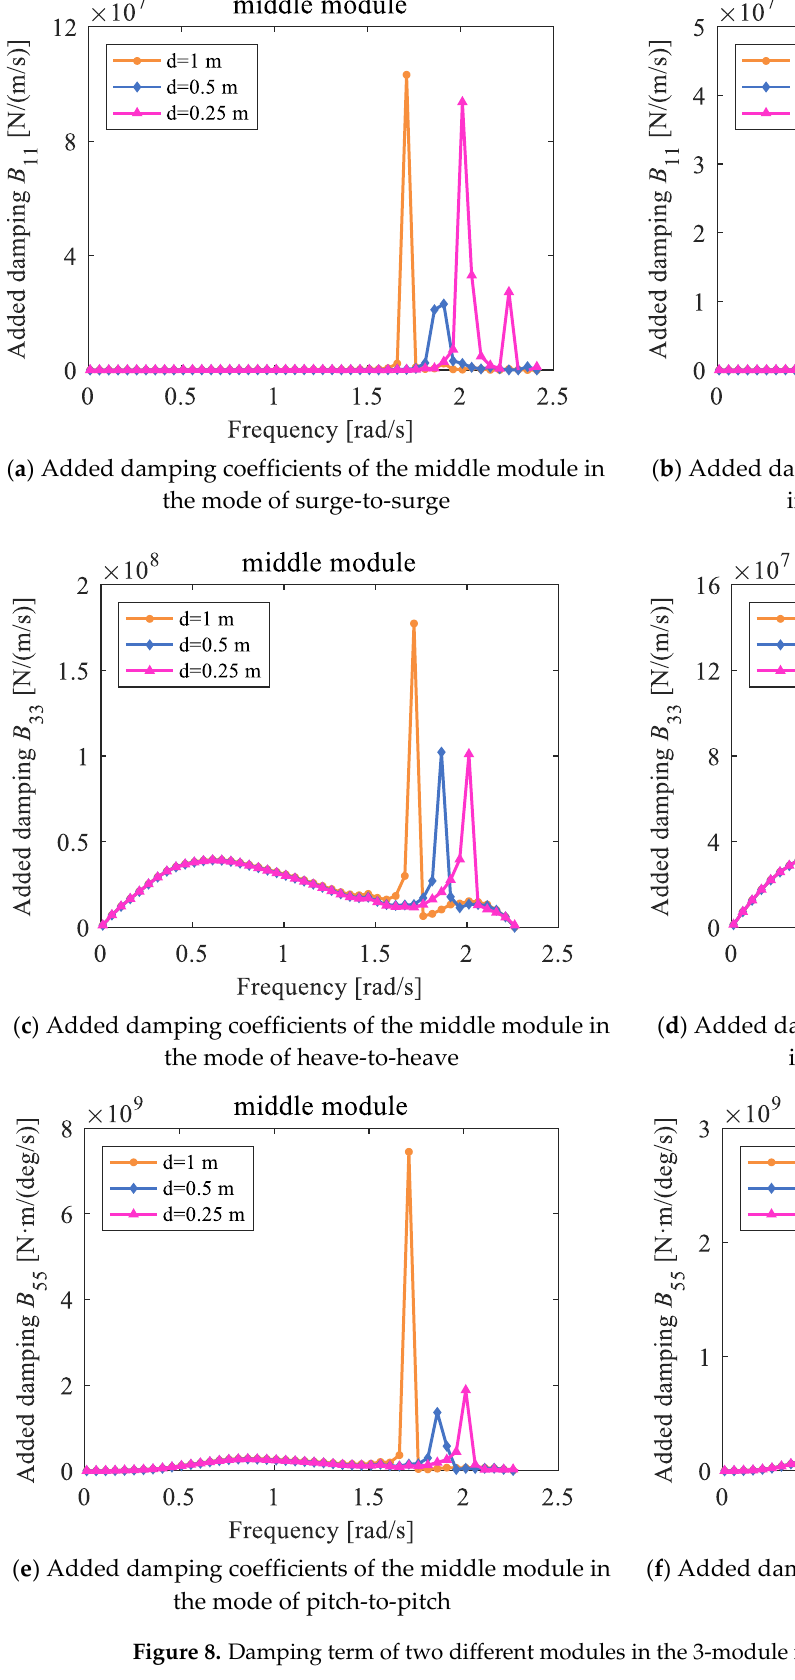
calculation accuracy at the resonant frequency in an ideal fluid, a new damped